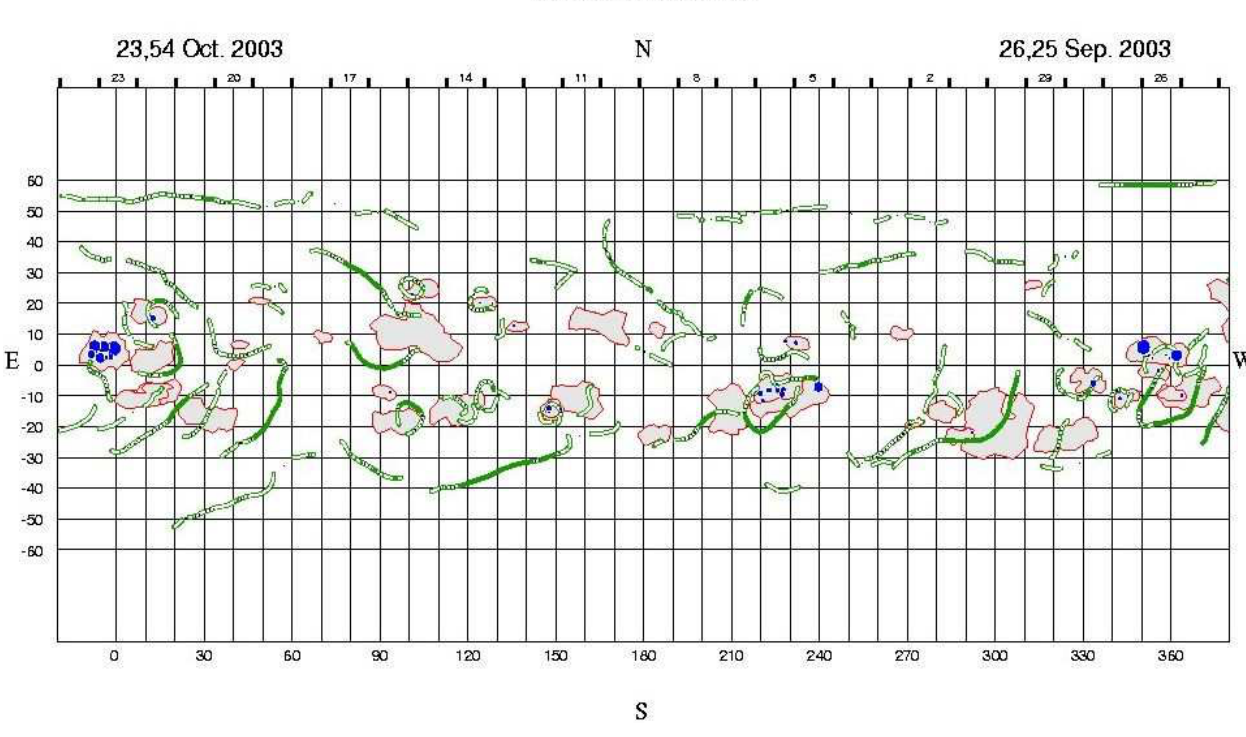
Fig. 2. Example of a Meudon Synoptic Map of Solar Activity.